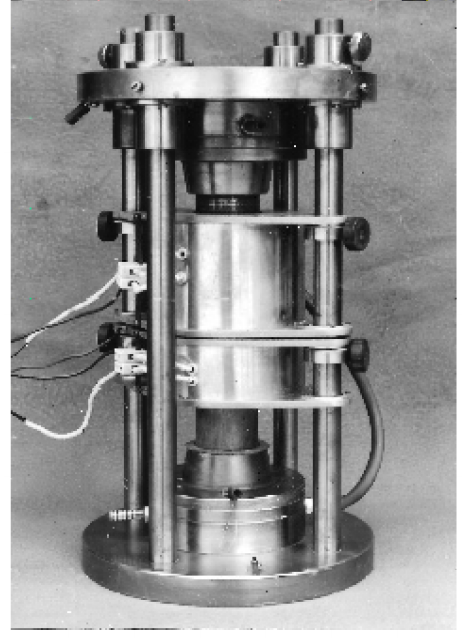
Figure 16. Bridgman device for electrical investigations.